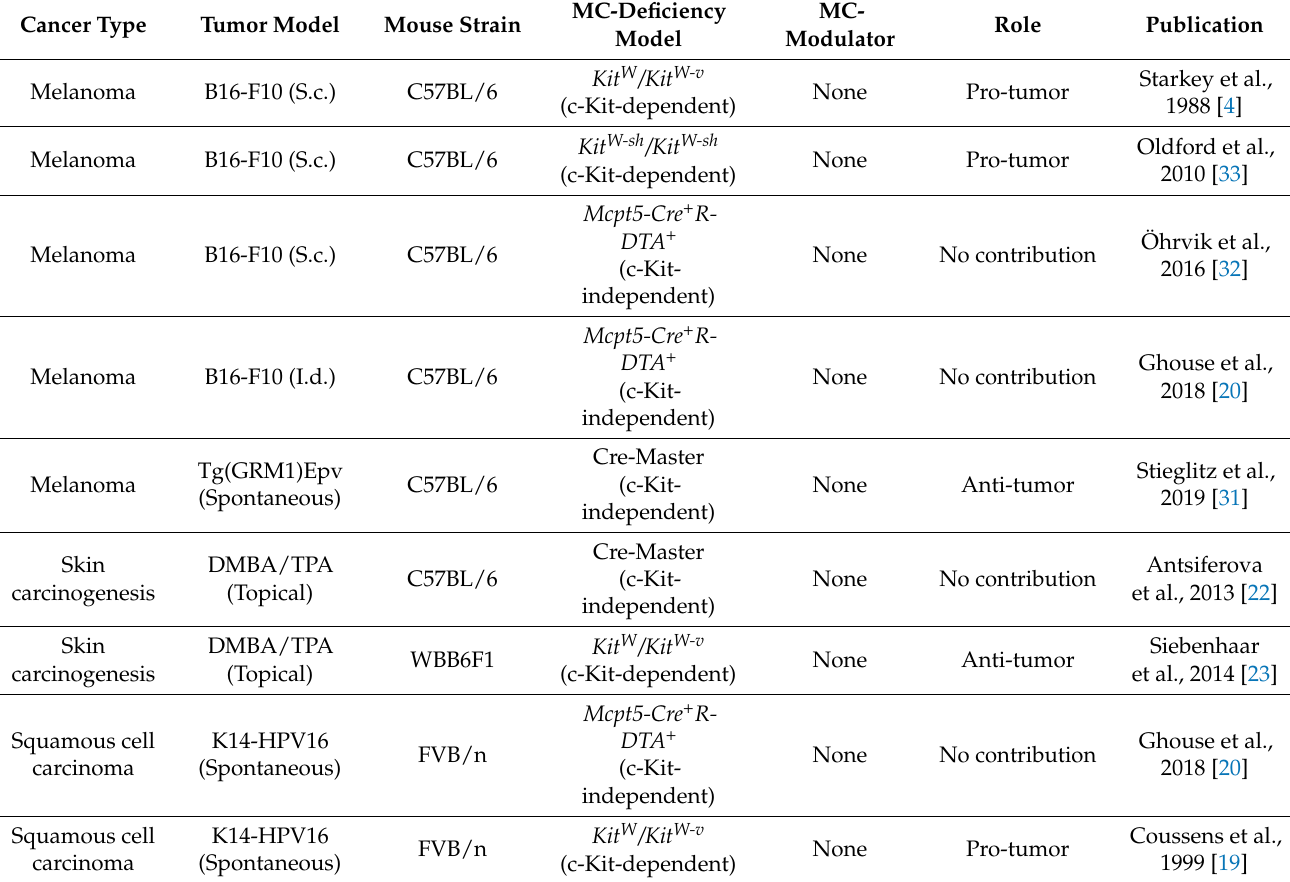
Table 1. Comparison of mast cell functions in mice with skin-derived